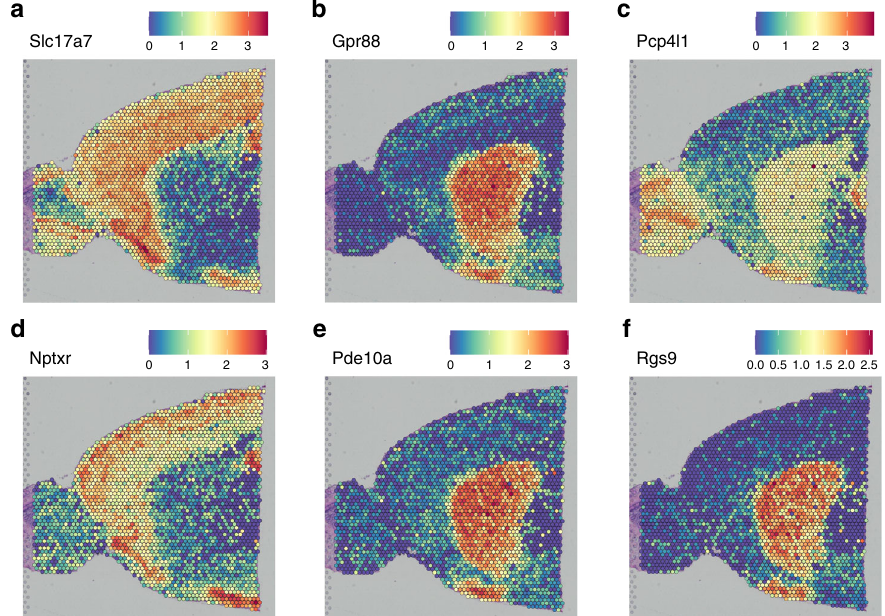
Fig. 7 Application of singleCellHaystack on spatial transcriptomics data. a – f Expression levels (normalized counts) per bead in the anterior1 slice of the mouse brain are shown for the top 6 high-scoring genes returned by haystack_2D . Each fi gure shows circles representing the 2696 beads superimposed on a slice of the anterior mouse brain. The locations of the circles correspond to the 2D coordinates of the beads and their colors re fl ect the expression of each